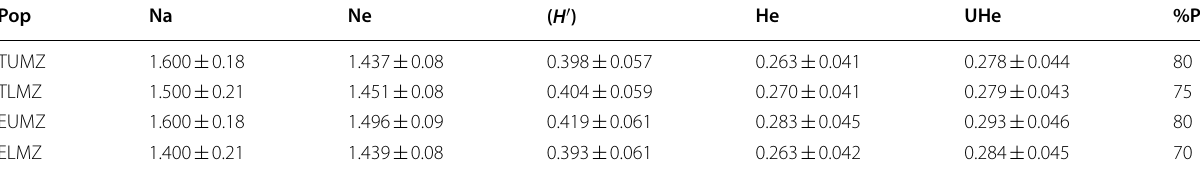
Table 6 Mean number of different alleles (Na), number of effective alleles (Ne), Shannon’s Information Index (H ′ ), expected heterozygosity (He), Unbiased expected heterozygosity (UHe), and percentage of polymorphic loci (% P) of indigenous rhizobia populations based on ARDRA data